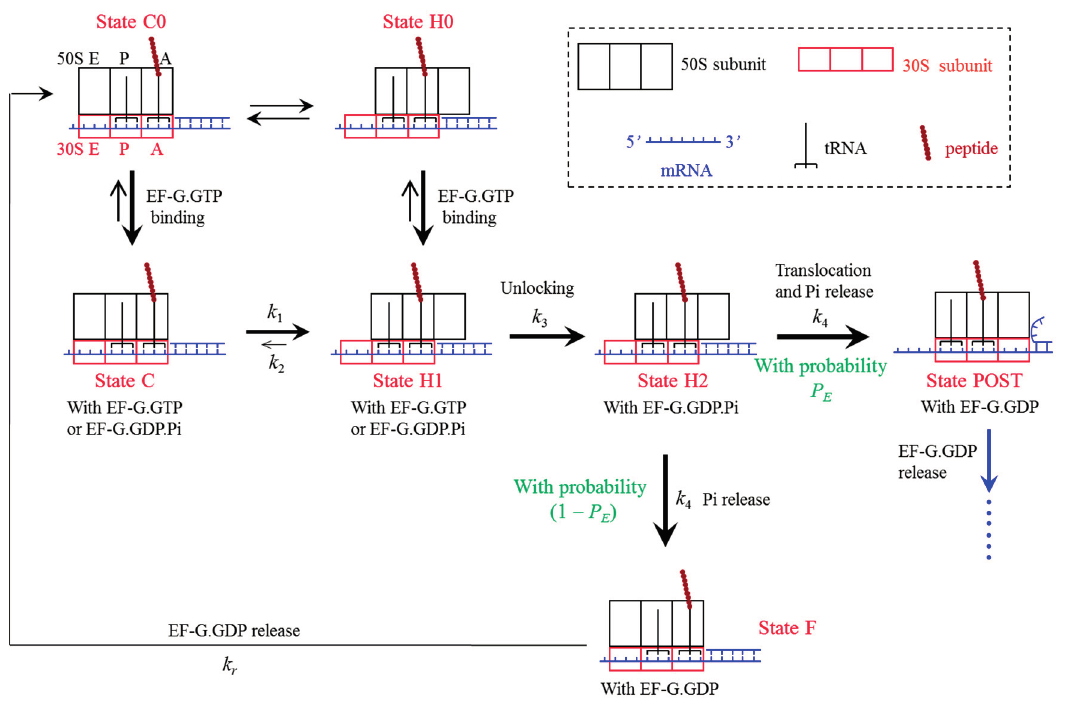
Figure 8. Model of ribosomal translocation through the mRNA duplex (see text for detailed